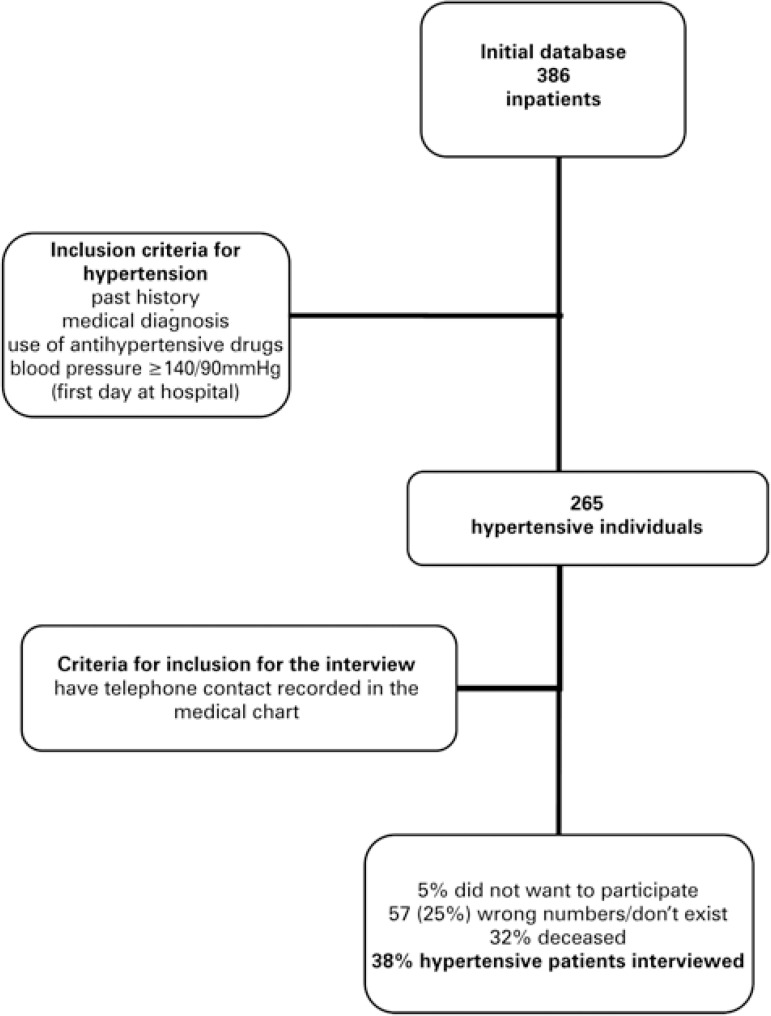
Flowchart of inclusion of hypertensive patients in the study